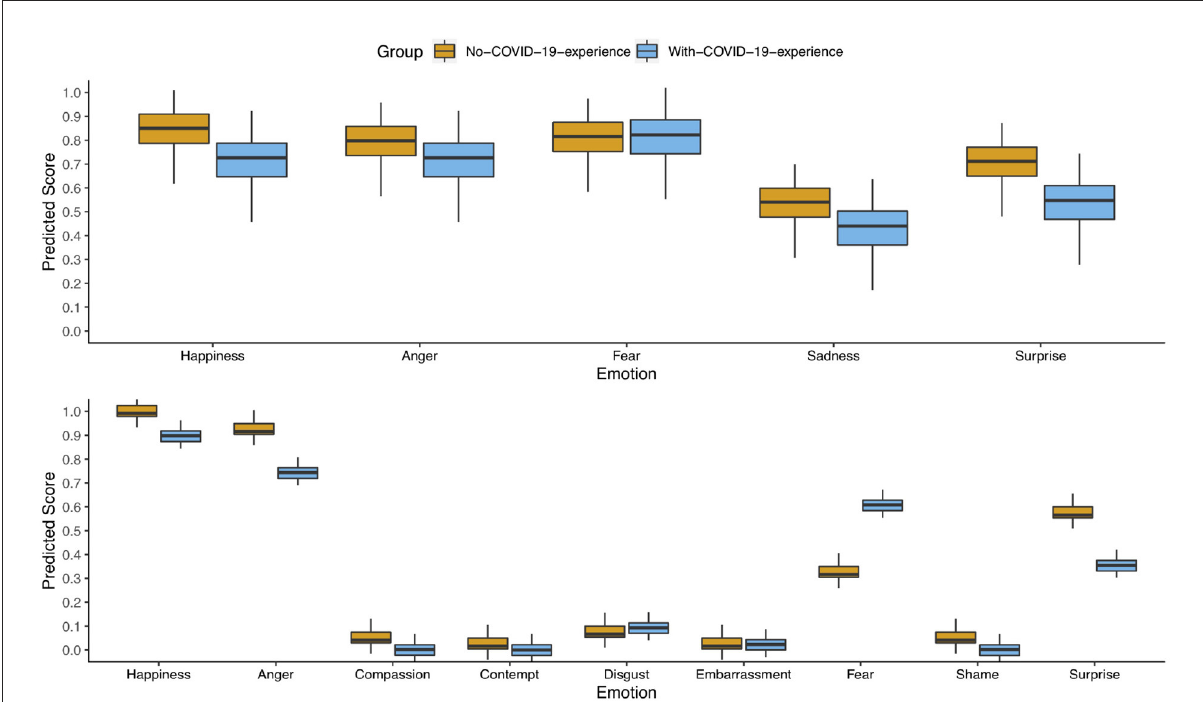
FIGURE1 Children’s predicted labeling score based on the according models in the Child Faces Task (top) and the Adult Faces Task (bottom) for the no-COVID-19-experience samples (orange) and the with-COVID-19-experience sample (blue). The higher the score, the more accurately children labeled the emotions depicted in the